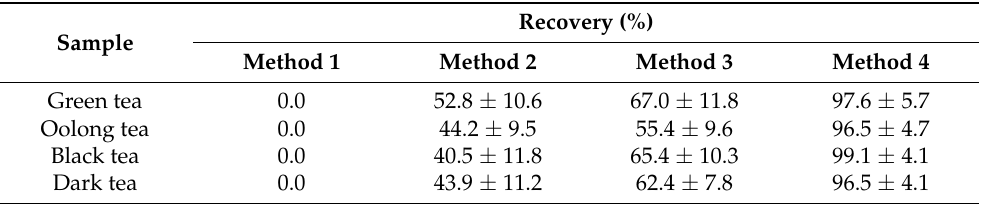
Table 1. Recovery of the four sample pre-treatment methods for PAT ( n =